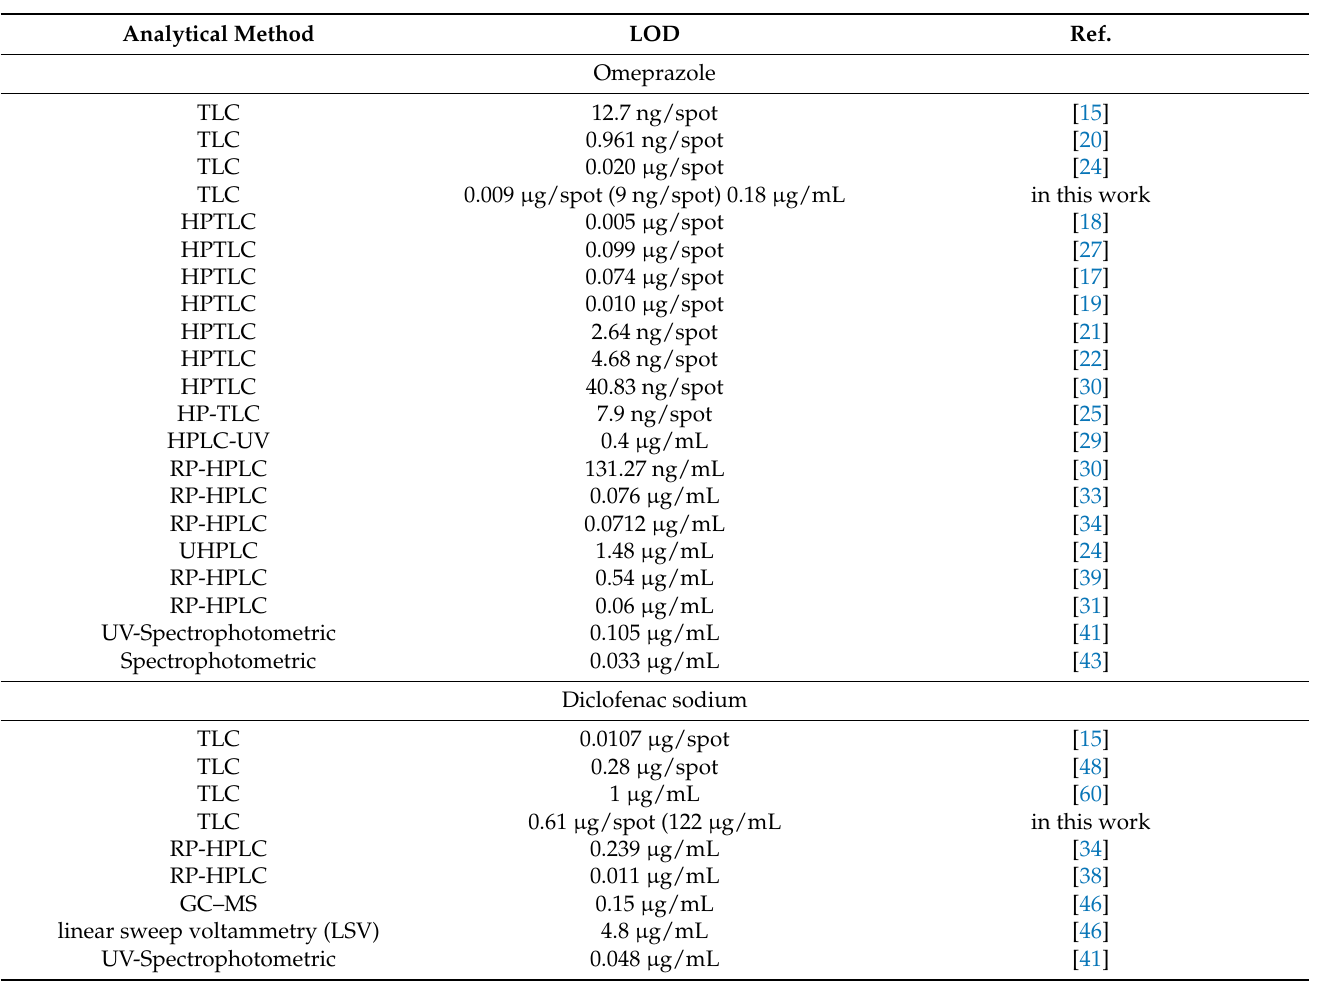
Table 8. Comparison of the limit of detection of omeprazole and diclofenac sodium determined in different pharmaceutical